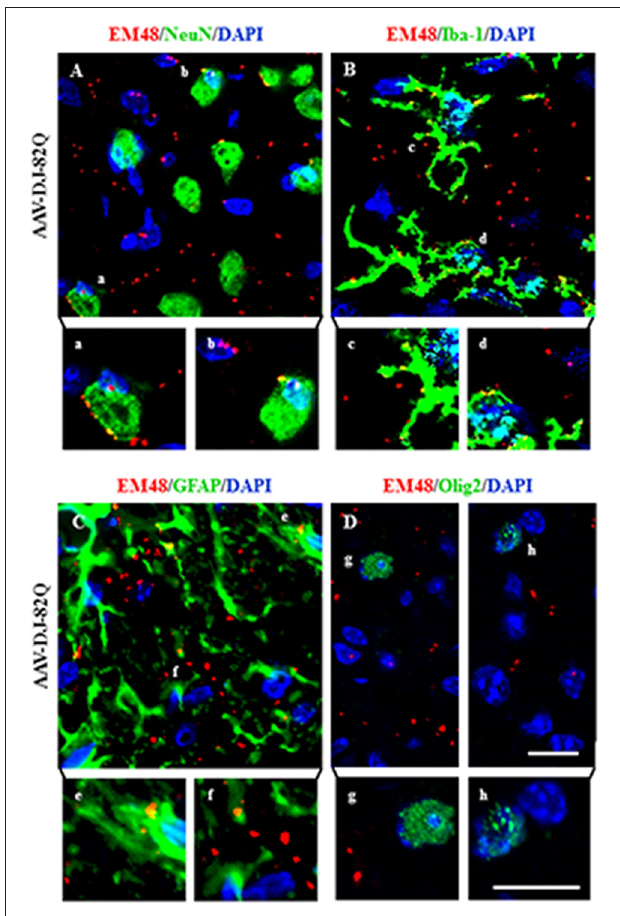
FIGURE 4 | AAV-DJ-82Q vector successfully infects neurons, microglia and astrocytes. Eight weeks after the AAV-DJ-82Q-injection, the striatal sections ( n = 2 per brain) from sham, AAV-DJ-18Q and AAV-DJ-82Q groups ( n = 7 per group) were analyzed by double immunofluorescence stain using anti-EM48, NeuN, Iba-1, GFAP and Olig2 antibodies (A–D) . Lower panels in (A–D) display high magnification micrographs of the areas marked with (a–h) in upper panels. Scale bar denotes 50 µ